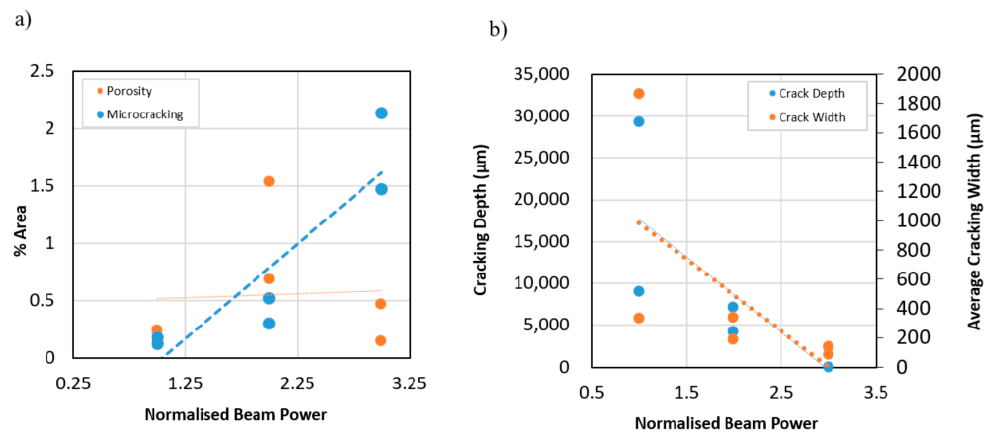
Figure 8. Influence of normalised beam power on ( a ) microcracking and porosity in the AB state; ( b ) cracking post HIP.